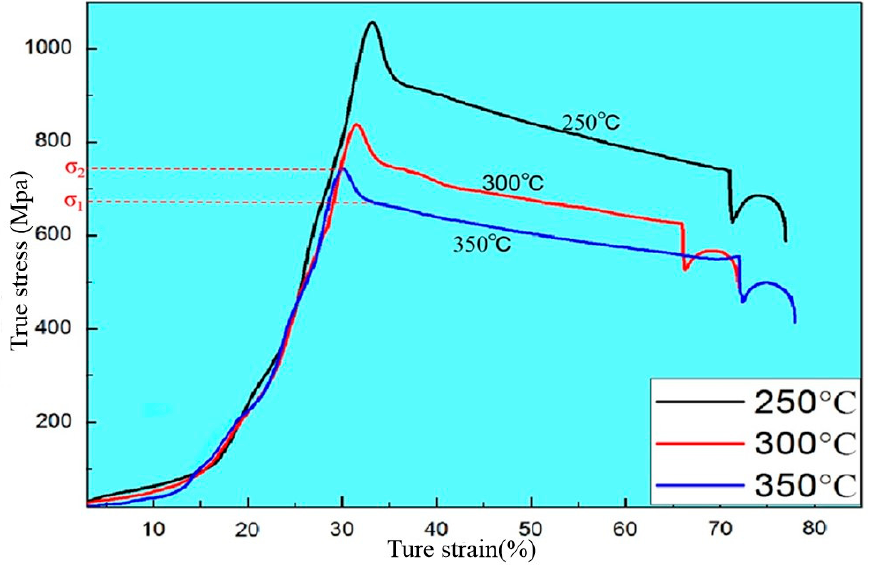
Figure 4. Typical compressive true stress-true strain curves of Mg-2Y-1Zn-0.6Zr alloy deformed at different temperatures.